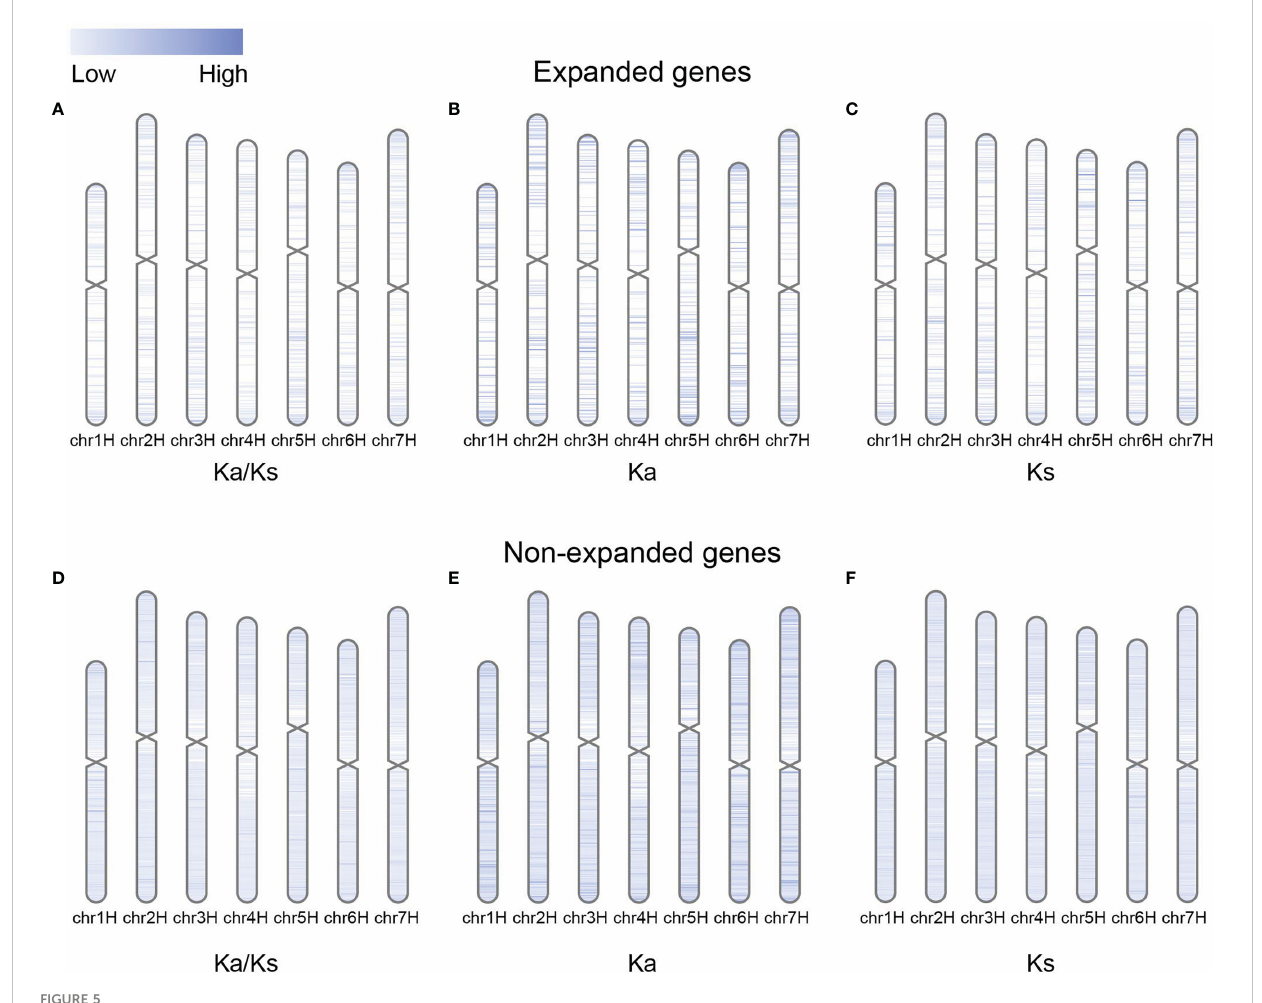
FIGURE 5 Distributions of Ka/Ks, Ka, and Ks values for expanded and non-expanded genes alongside the chromosome by comparing barley with rye. (A – C) Ka/ Ks, Ka, and Ks values for expanded genes. (D – F) Ka/Ks, Ka, and Ks values for non-expanded